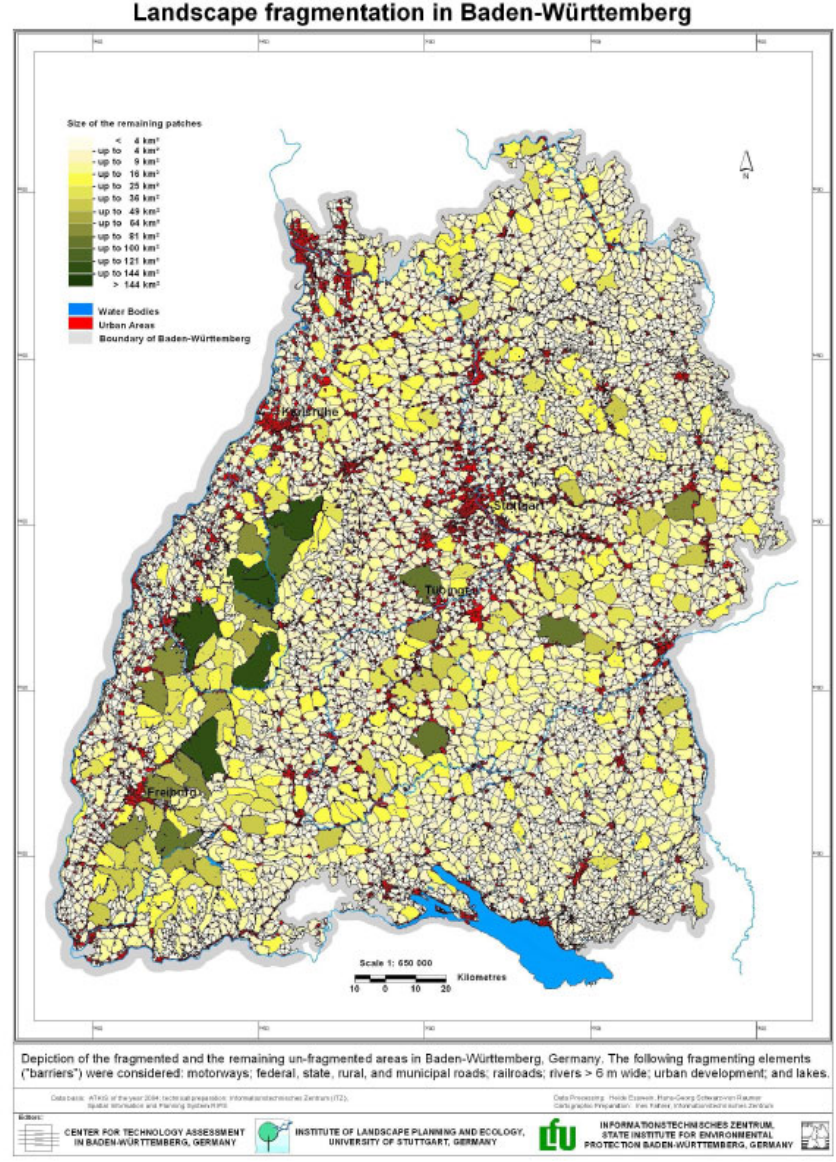
Fig. 3. Landscape fragmentation due to transportation infrastructure and urban development in Baden- Württemberg in 2004. The colors of the patches indicate their sizes. Only six patches >100 km² and 22 patches >50 km² remain. The following fragmenting elements (barriers) were considered: motorways; federal, state, rural, and municipal roads; railroads; rivers >6 m wide; urban development; and lakes. (Click here to view or download a high resolution pdf version. File size: 1301